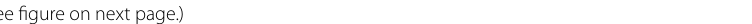
0.001(See figure on next Fig. 4 The effects of hucMSC on METTL14 overexpression on HNPC are inhibited by miR-26a-5p inhibitor. A Cell viability, B LDH activity, C , D pyroptosis, E – G expression of METTL14, NLRP3, caspase-1, and GSDMD-N, and H content of IL-1β and IL-18 were measured in D-HNPC transduced with the METTL14 expression vector and treated with hucMSC-exo from hucMSC transfected with miR-26a-5p inhibitor (hucMSC/inhibitor-exo) or NC (hucMSC/NC-exo). *** P <